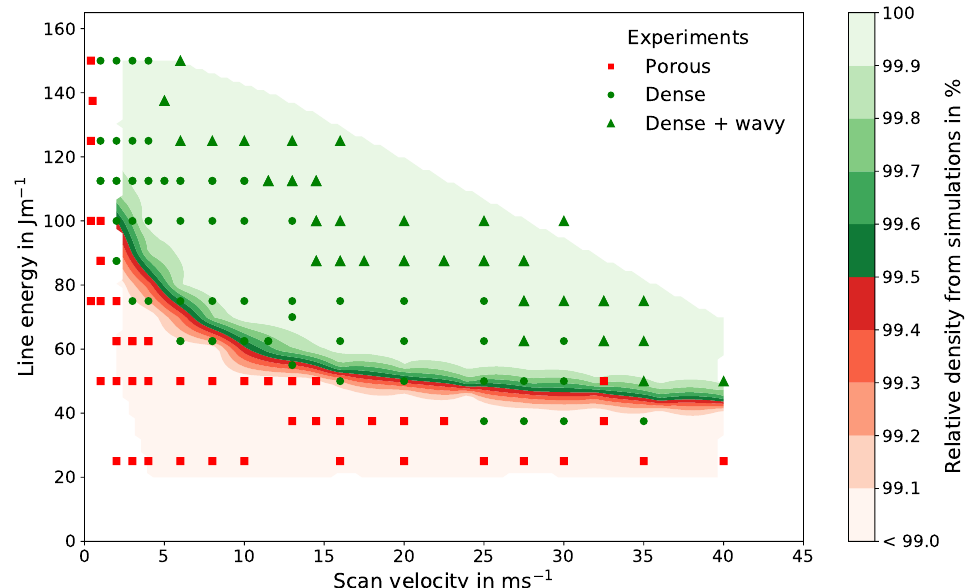
Figure 4. Process window for selective electron beam melted Ti-6Al-4V with a line offset and nominal powder layer thickness of 50µm and a powder bulk density of 55%. Experimental results are classified into porous (red squares), dense (green circles), and wavy (green triangles). Numerical results are represented by a relative density